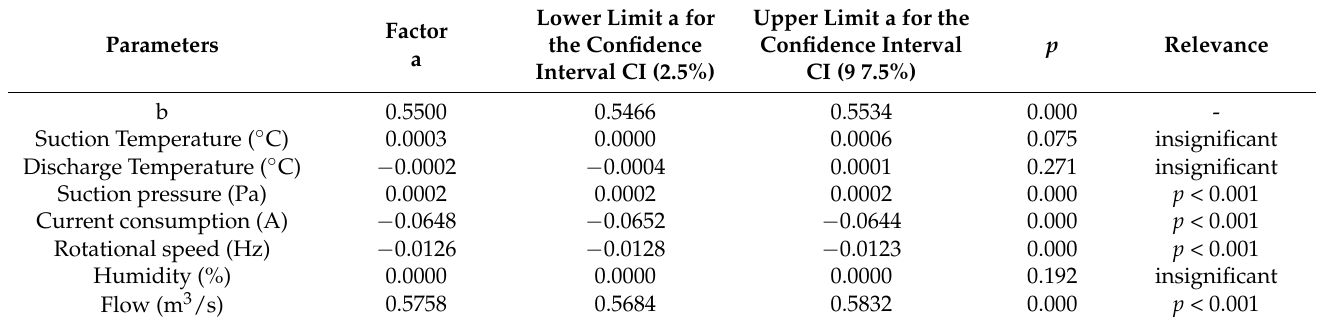
Table 2. Correlations (Pearson) between the measured parameters and the fan